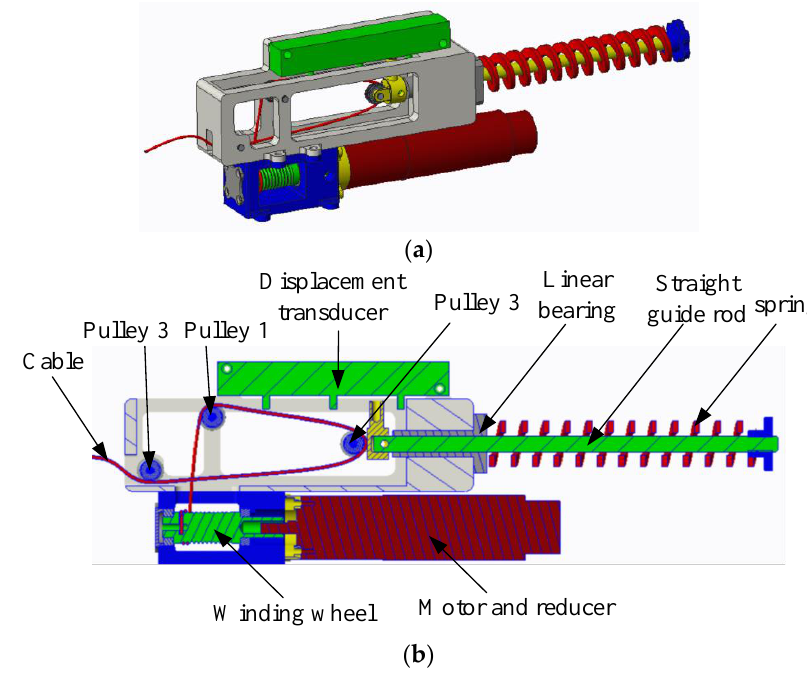
Figure 4. Schematic diagram of NSECA. ( a ) Appearance drawing. ( b ) Profile of the actuator.